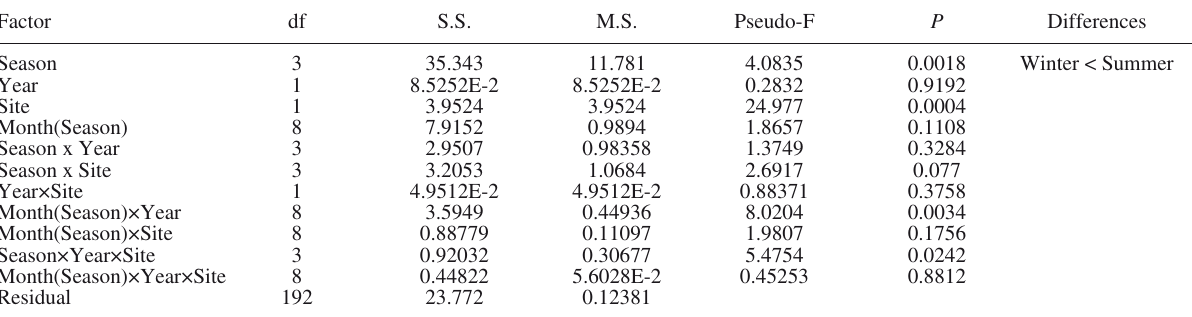
Table 1. – Results of four-way ANOVA testing for differences in the GI of H. sanctori among seasons, years, sites and months within seasons. Factor df